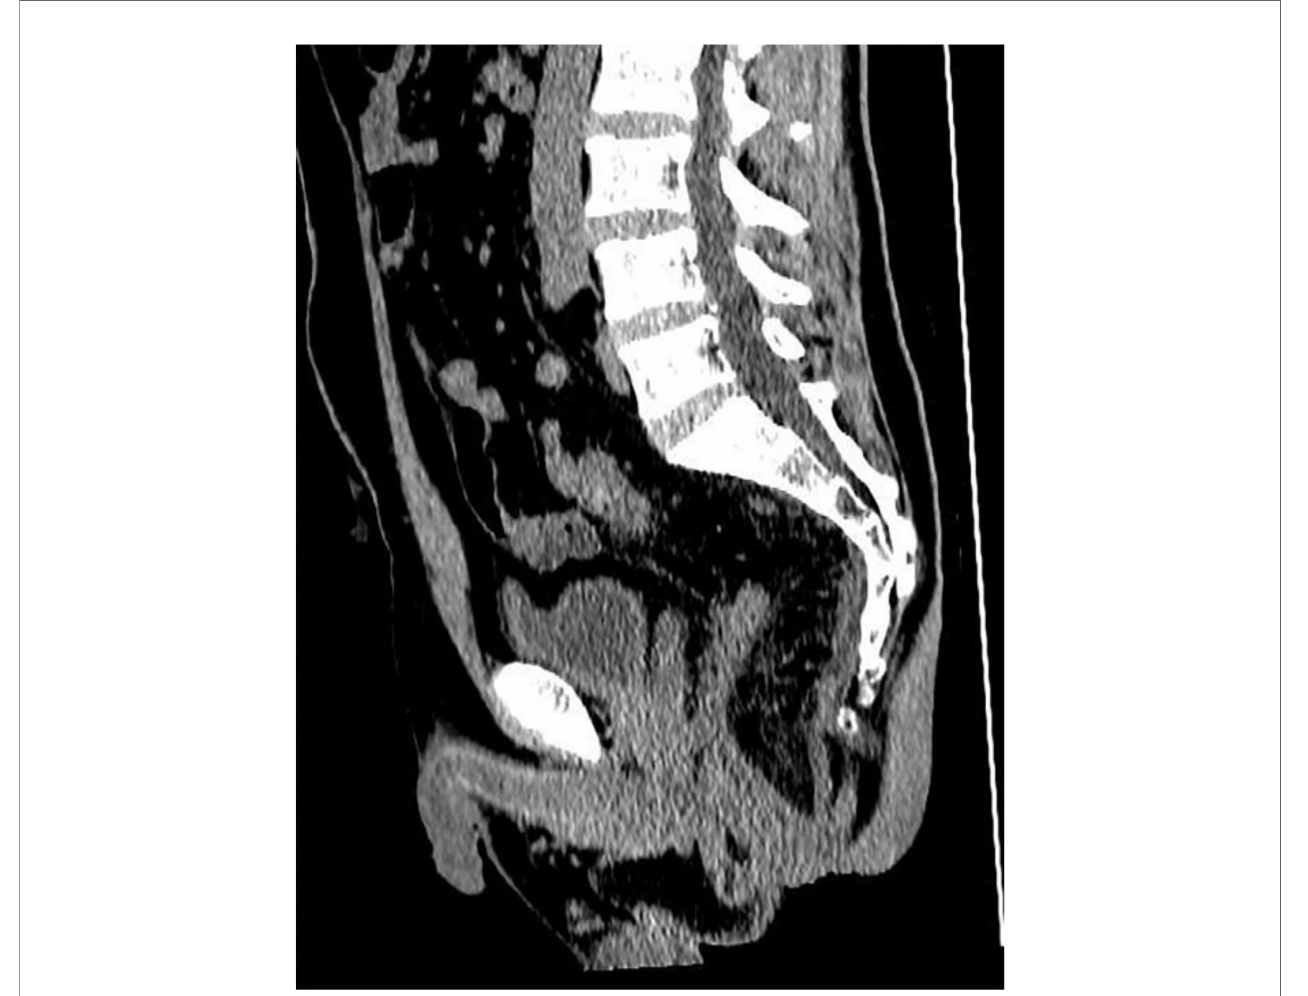
FIGURE 2 | CT image after removing the trans-anastomotic drainage tube (postoperatively day